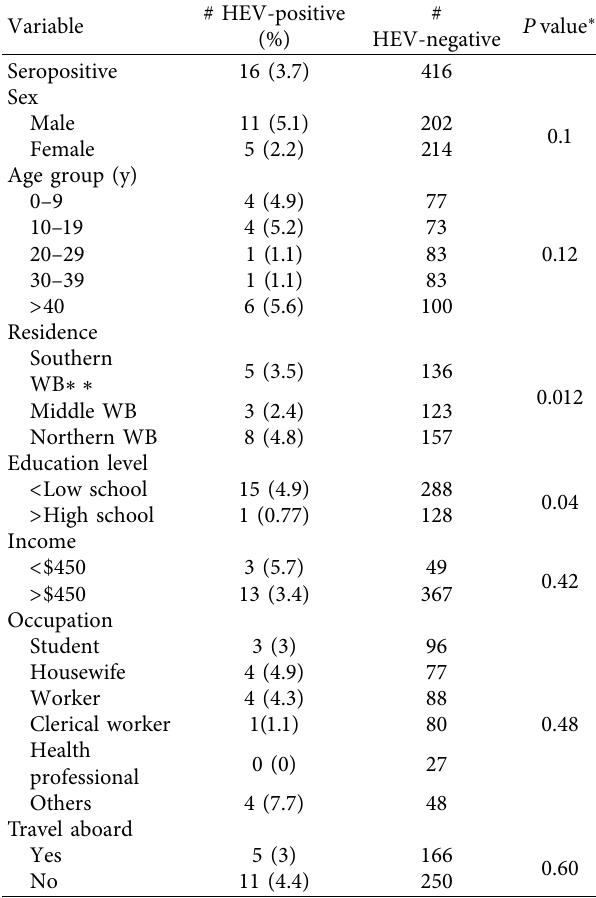
Table 3: Possible demographic and socioeconomic risk factors affecting the prevalence of the hepatitis E